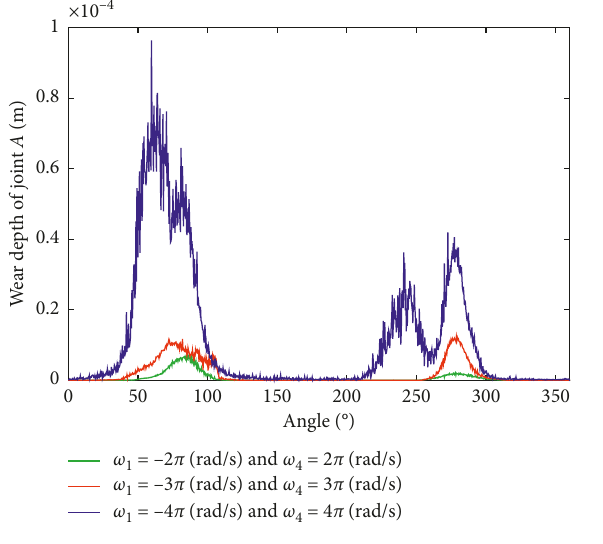
Figure 35: Wear depth at joint A .